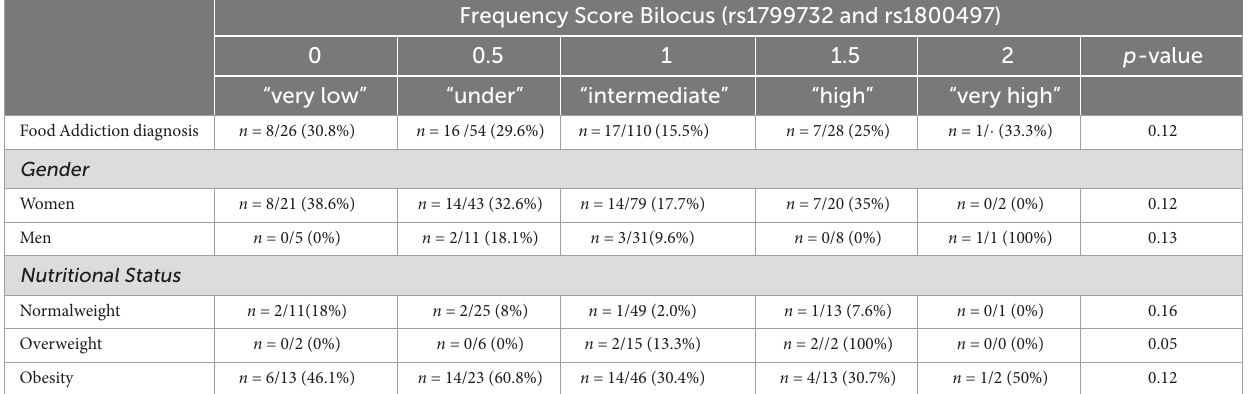
TABLE 6 Prevalence of food addiction by Bilocus score (rs1799732 and rs1800497), gender and nutritional status in Chilean university